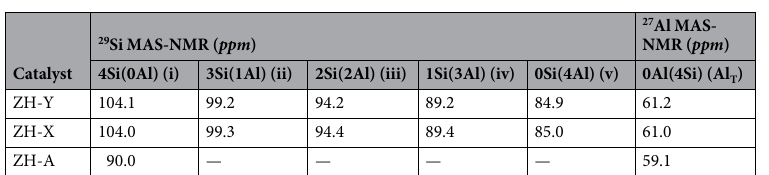
Table 2. NMR Chemical shift values of various